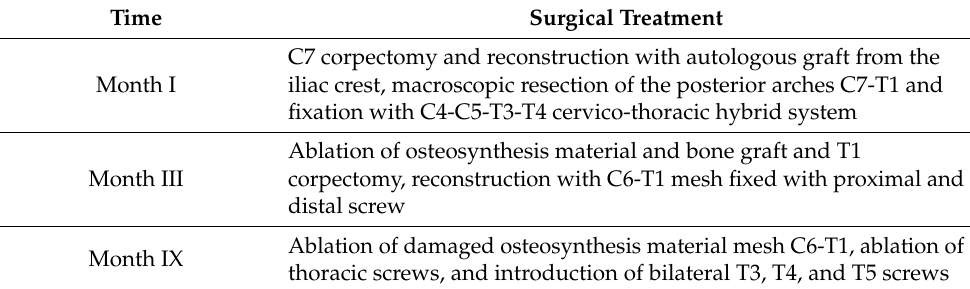
Table 3. Neurological deficits and recovery treatment over time